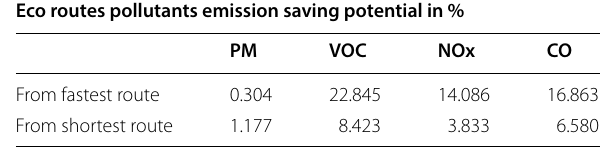
Table 7 Scenario 1 Case 1 eco route emission saving